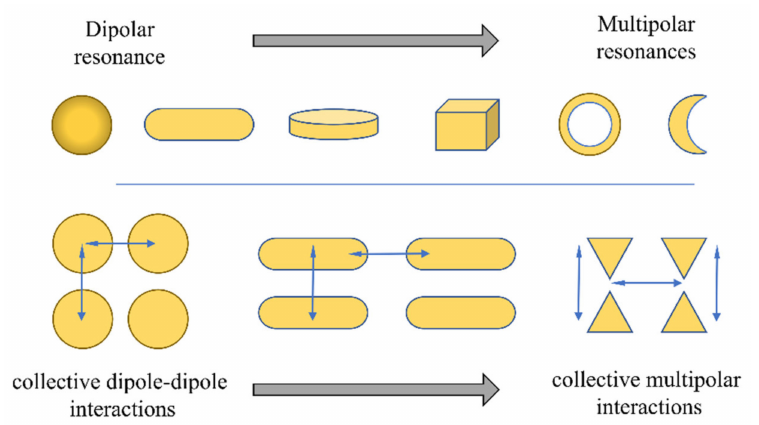
Figure 2. Schematic diagram for several NP nanostructures that are used in LSPR sensors, shifting from dipolar resonances to multipolar ones. These are presented in increasing order of tip sharpness. The lower section represents the interparticle interactions in array nanostructures, that will also cause additional changes on the spectral